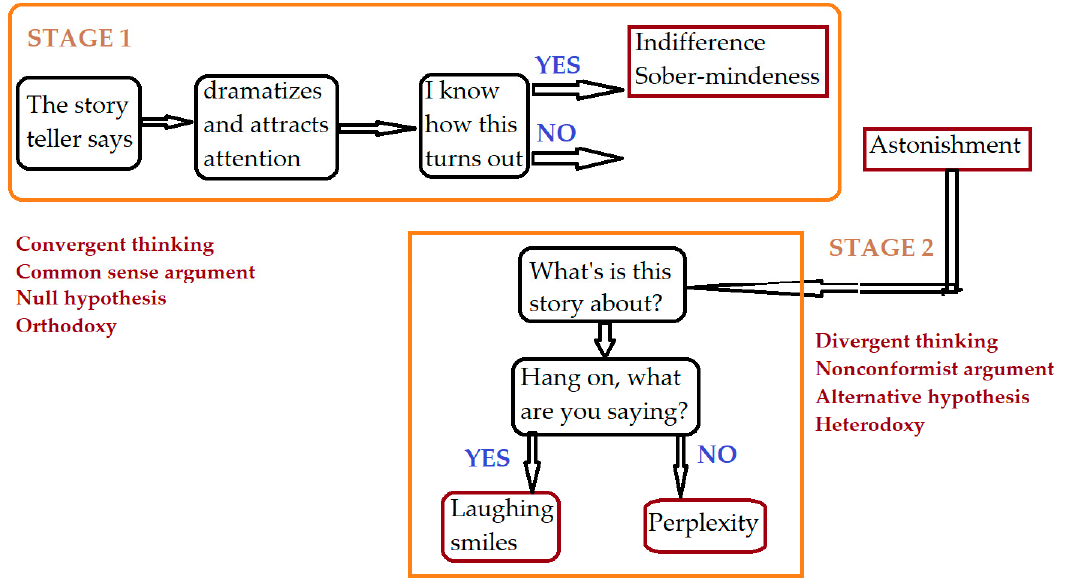
Figure 2. A variation of Suls’ incongruity resolution model adapted from Suls (1972, 1983).